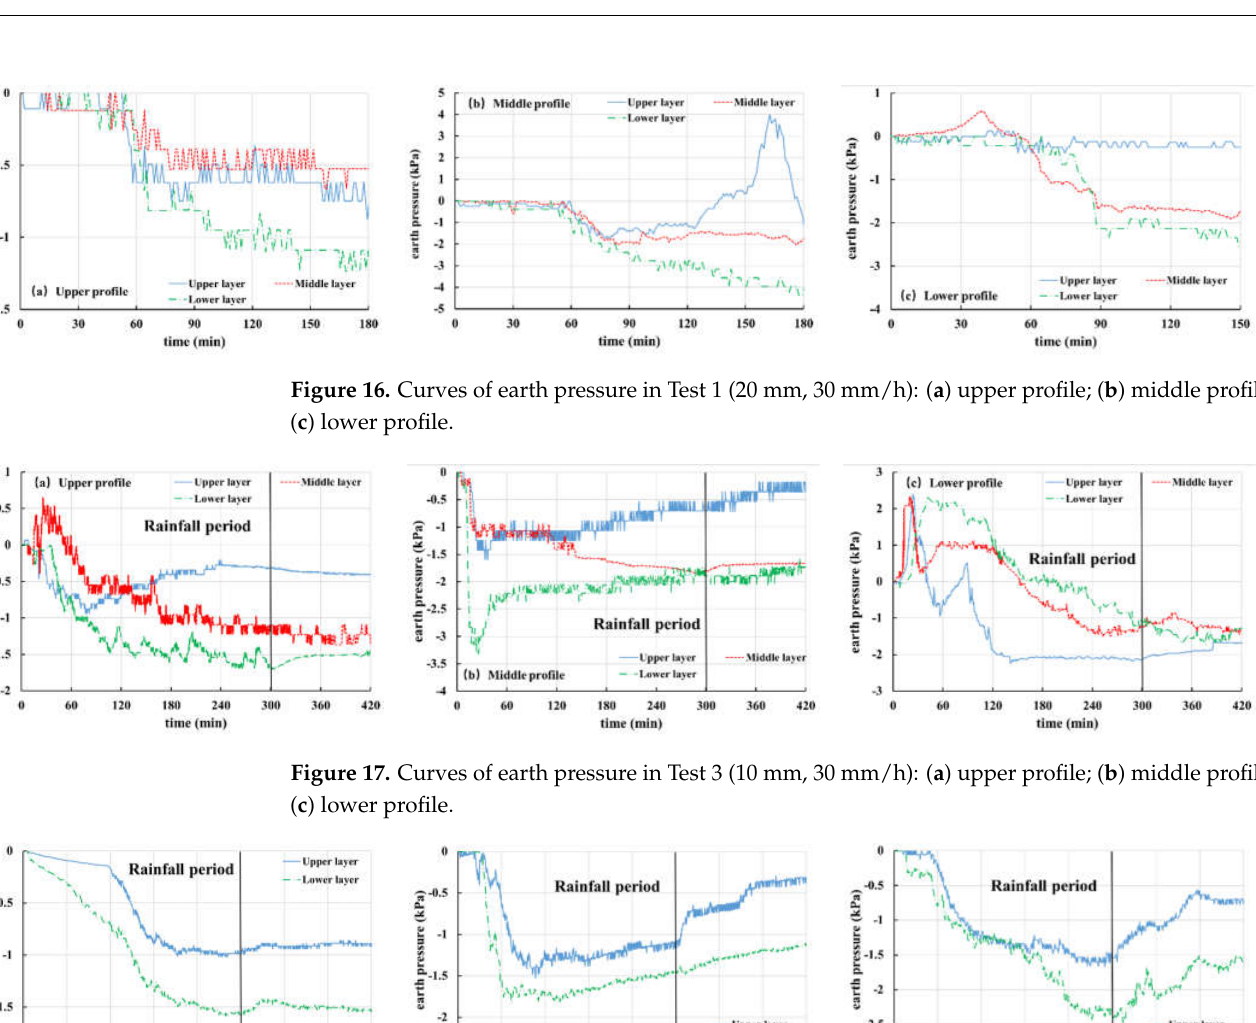
Figure 15. Curves of earth pressure in Test 2 (20 mm, 60 mm/h): ( a ) upper profile; ( b ) middle profile; ( c ) lower profile.